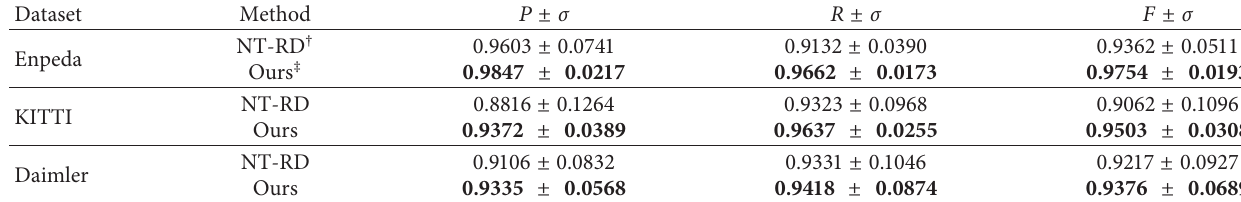
Table 1: Road detection algorithm performance comparison of our and NT-RD